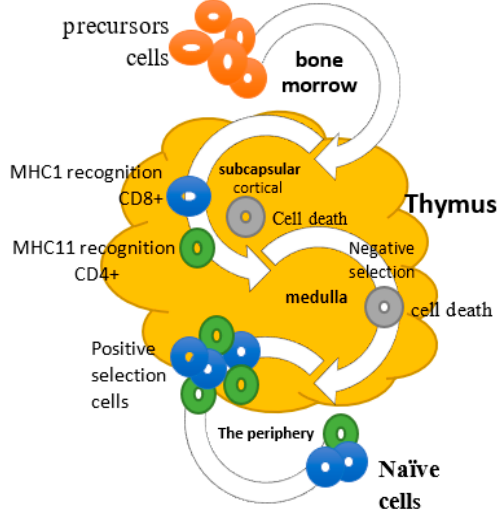
Figure 1. Overall role of the thymus gland in the development of T cells.